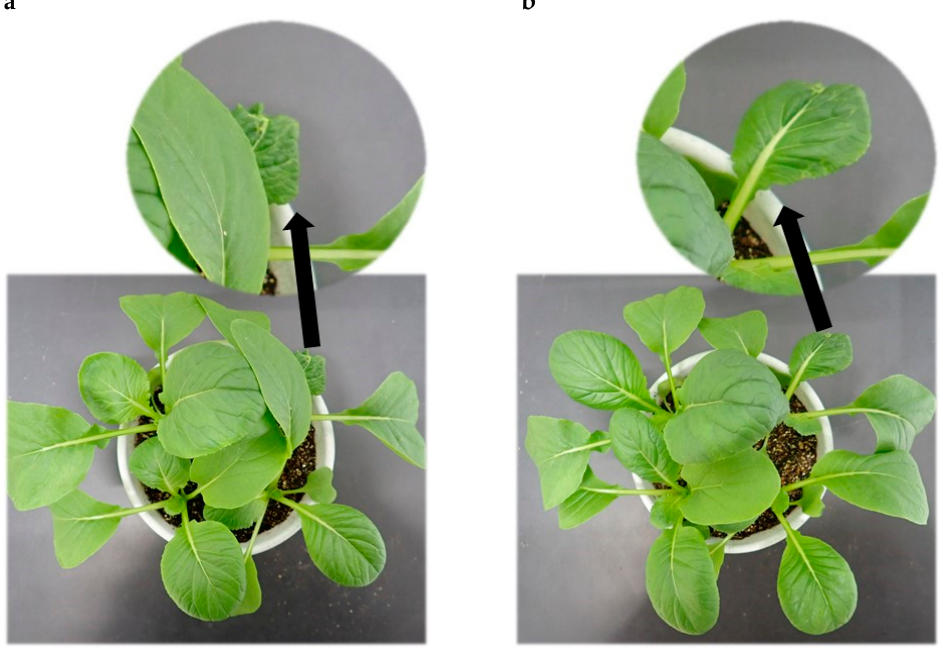
Figure 5. Wilting of komatsuna leaves. Pictures were taken at day 19 ( a ) and day 21 ( b ) and show wilting of komatsuna leaves after being sprayed with 1000 ppm PDJ.